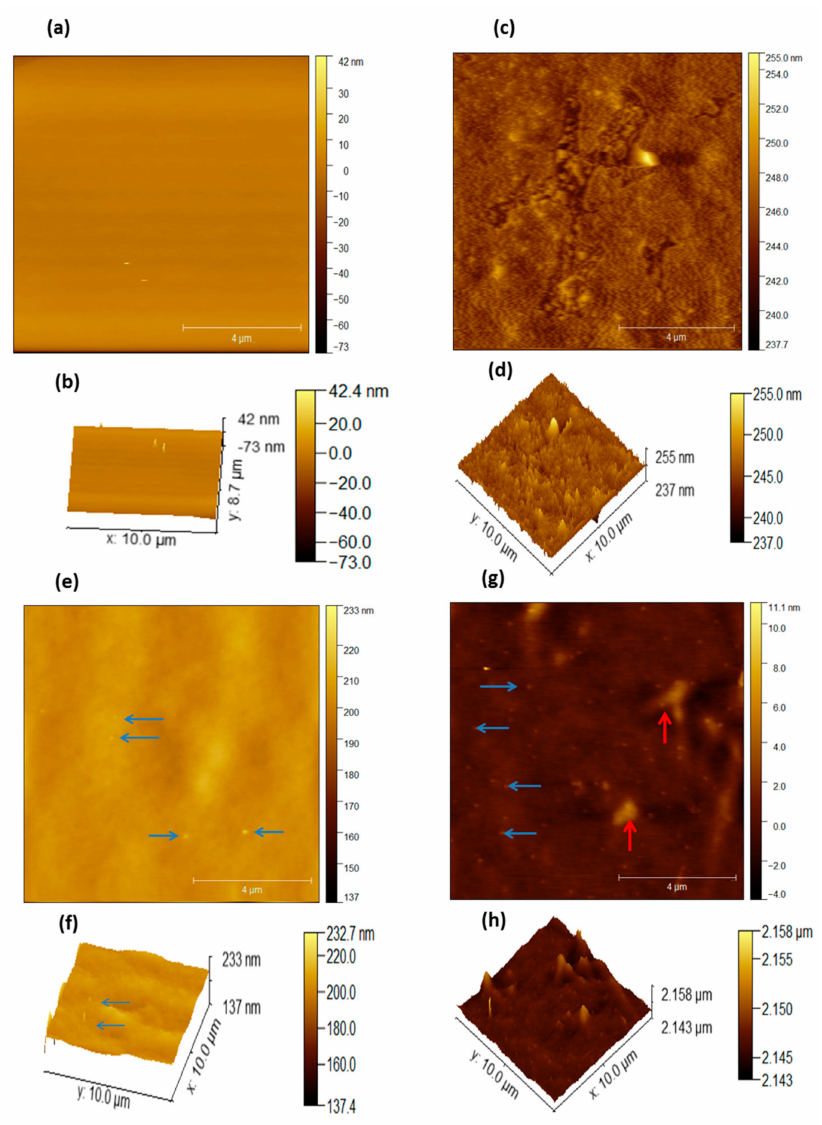
Figure 5. AFM topographical and 3D images of ( a , b ) PVA membrane; ( c , d ) PVA membrane with [Tmi][Trif]; ( e , f ) PVA membrane with Cdots / [Bmim]Cl / [Tmi][Trif]; ( g , h ) PVA membrane with CdotsCHI /